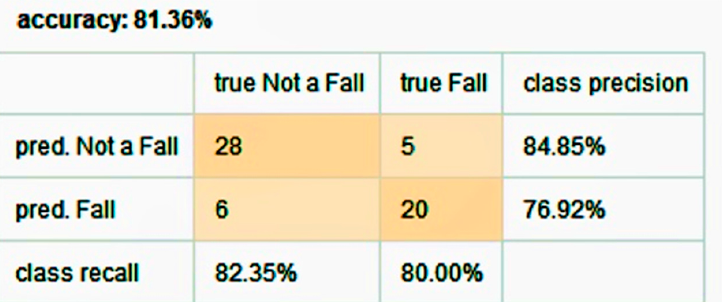
Figure 4. Confusion matrix (tabular view) of the RapidMiner process shown in Figure 2, which is a